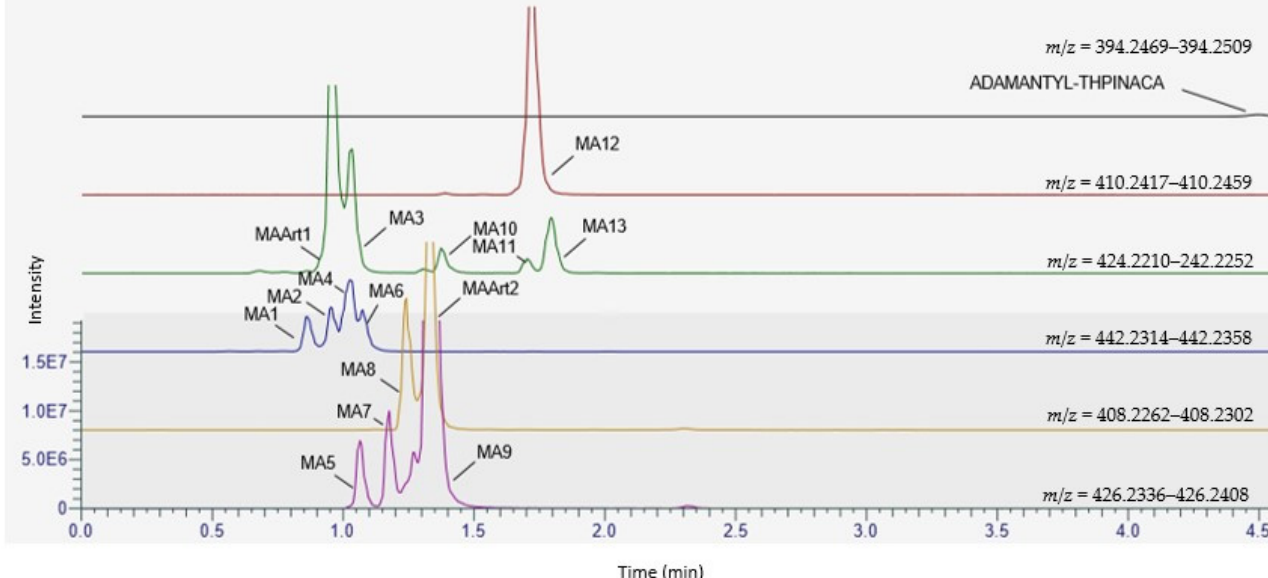
Figure 4. Chromatogram showing the mass traces of the detected metabolites (and artefacts) of ADAMANTYL-THPINACA after 2 h of incubation. The traces are normalized globally, with a maximum at 12% of the base peak (MA9).